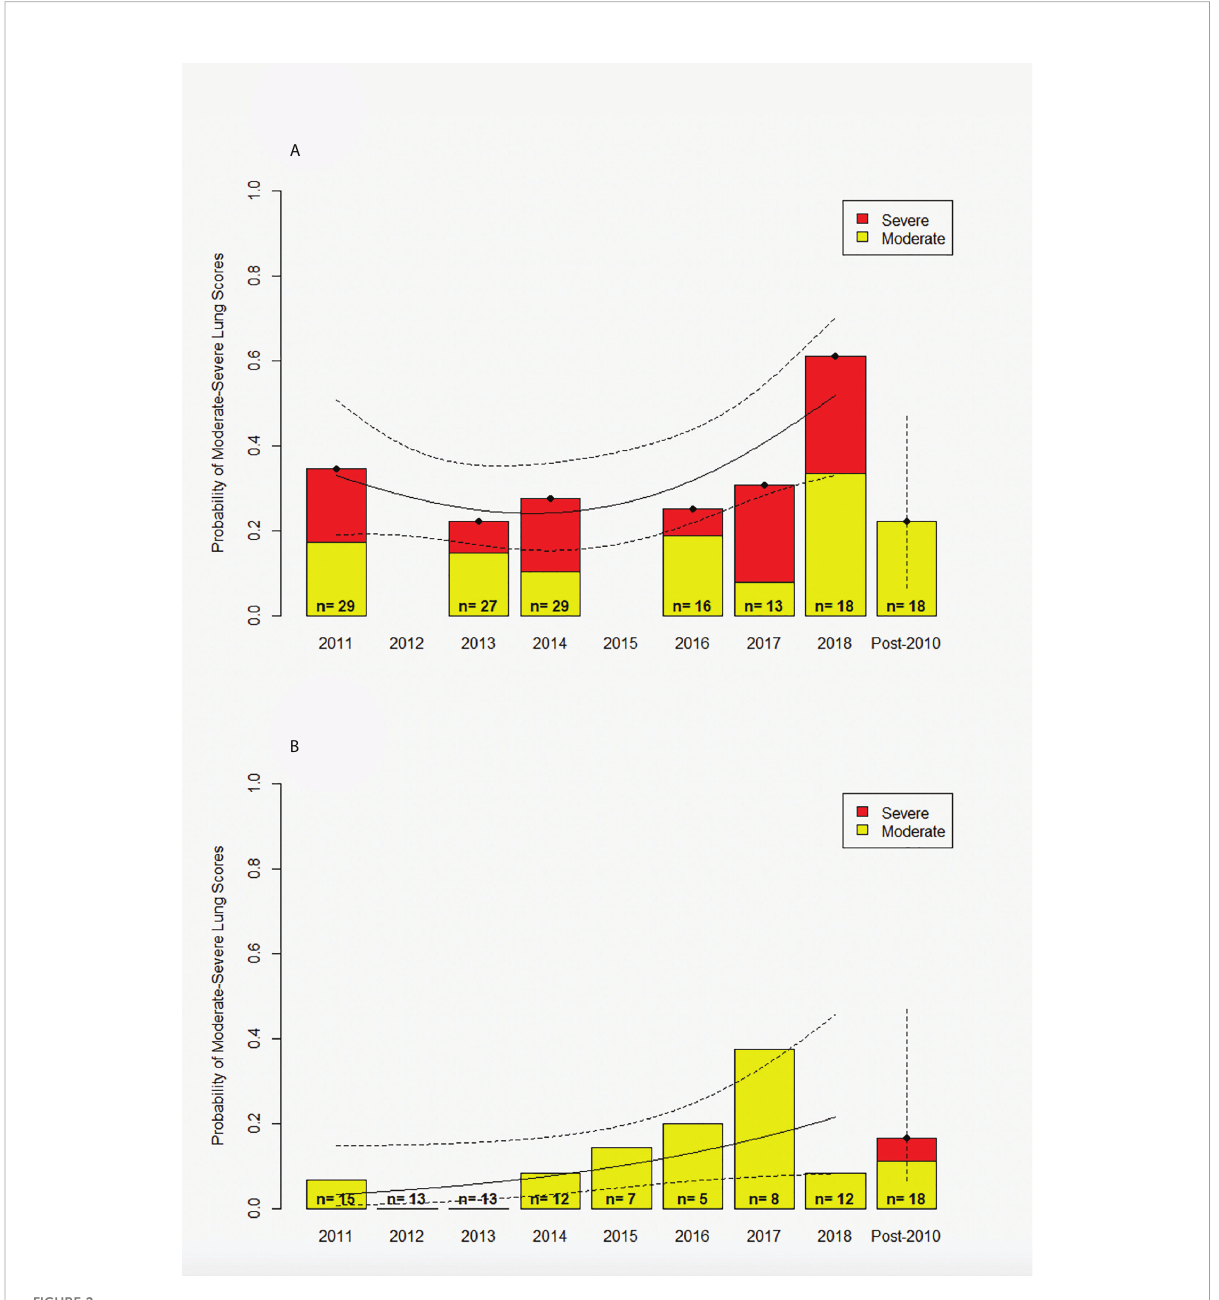
FIGURE 2 Probability of moderate and severe lung scores for (A) Barataria Bay and (B) Sarasota Bay. Probability for dolphins alive at the time of the spill is strati fi ed by year (2011-2018); lung scores for dolphins born after 2010 were pooled within each site due to limited samples sizes ( ‘ Post-2010 ’ ). Red and yellow portion of bars represent proportion of severe and moderate scores, respectively. Fitted curves (solid) and 95% CIs (dashed curves) are from the Generalized Additive Model (GAM) with separate smoothing splines for sampling year (Barataria Bay p=0.0644, Sarasota Bay p=0.0655). Vertical dashed lines for post-2010 cohorts represent 95% binomial con fi dence